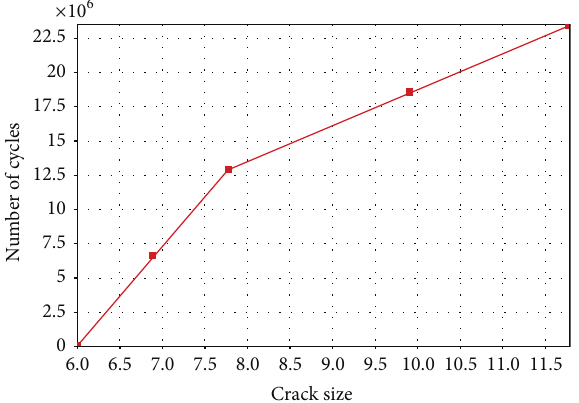
Figure 18: Relationship between loading cycle and crack size of a longitudinal